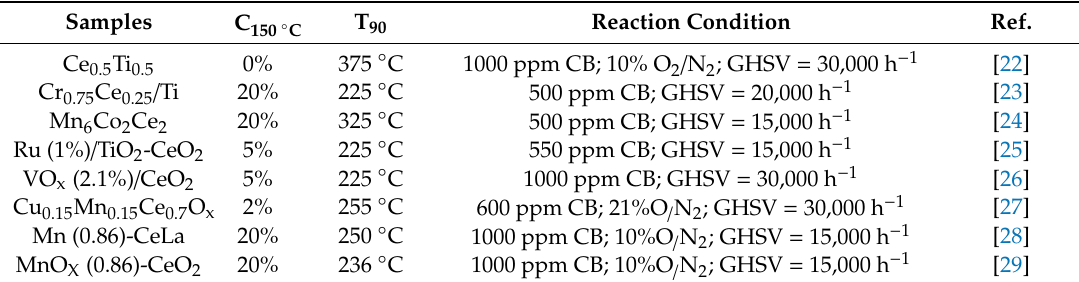
Table 1. Research about the catalytic combustion of CBs over metal oxide